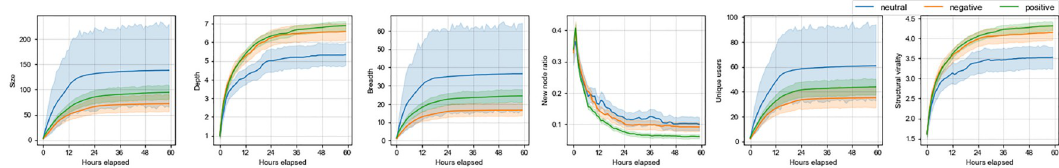
Fig 14. Speed of vulnerability discussion spread on Reddit across cascades started by posts with different polarities.